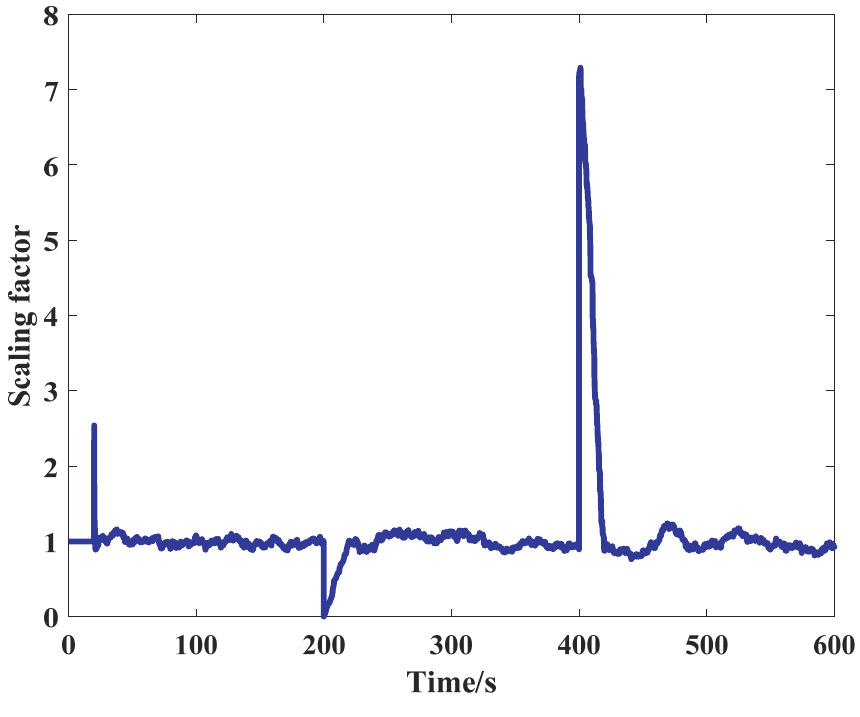
Figure 5. The change of scaling factor.